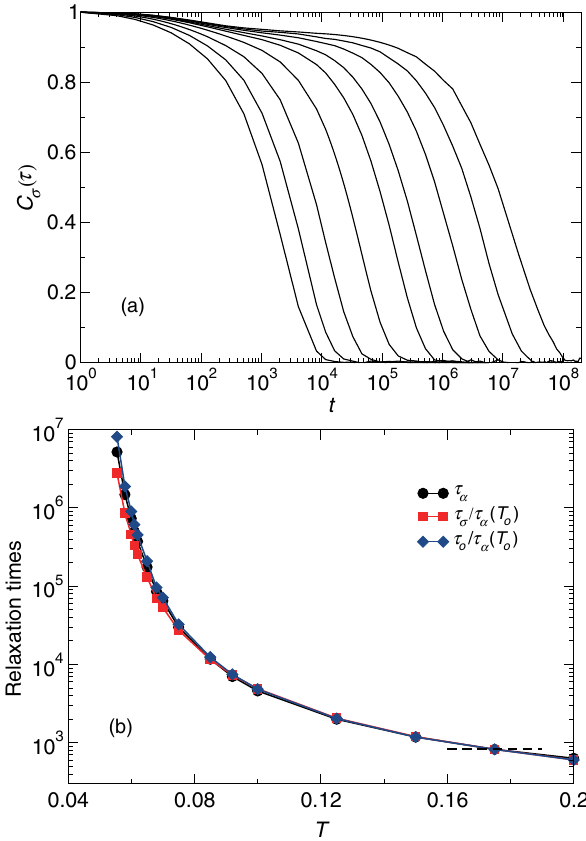
FIG. 11. Time series of individual displacement Δ r ð t Þ and diameter value σ ð t Þ for two tagged particles in the nonadditive model of Sec. IV C with ϵ ¼ 0 . 2 at T ¼ 0 . 0555 . Intermittent diffusion in real and diameter space is observed, with strong correlations between Δ r ð t Þ and σ ð t Þ highlighted with dashed lines, but we also observe many events in one observable that have no counterpart in the other, indicating that the correlation between the two observables is nonlocal.